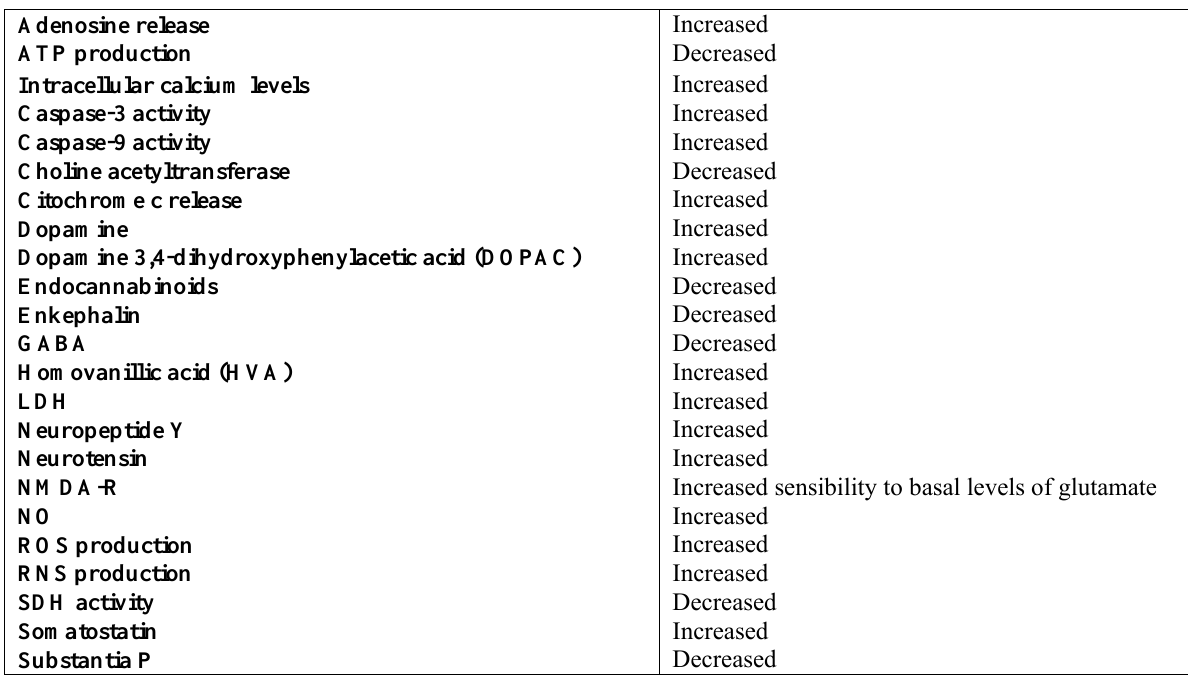
Table 2. Molecular changes induced by 3-NP in